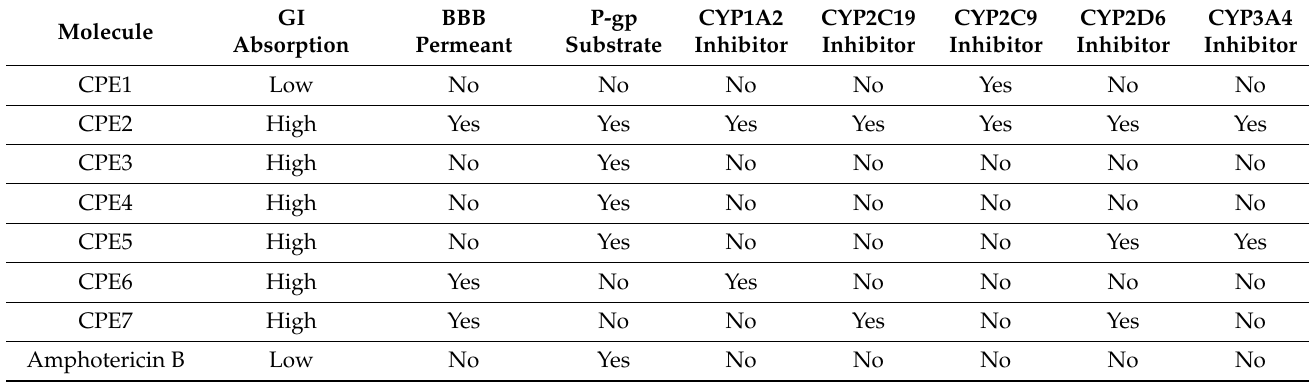
Table 2. Pharmacokinetics of selected and reference compounds. GI: Predicted gastrointestinal absorption. BBB: Predicted blood–brain barrier permeation. P-gp: Predicted substrate of P glycoprotein. CYP inhibitor: Likelihood of interactions with the five most common isoforms of cytochromes P450.